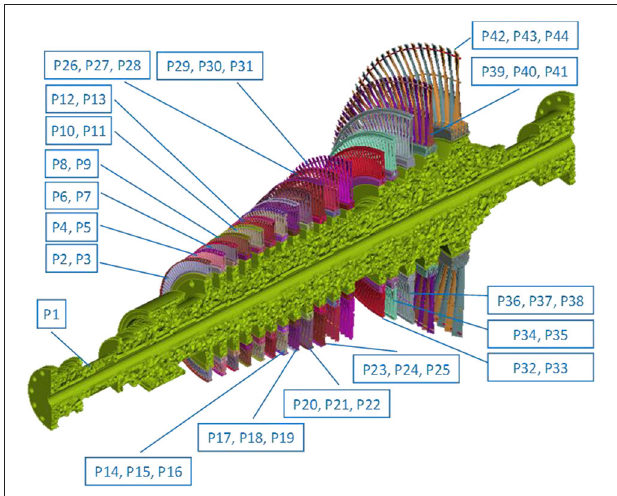
FIGURE 10 | Parts of the parameterized FE models of the intermediate pressure turbines.